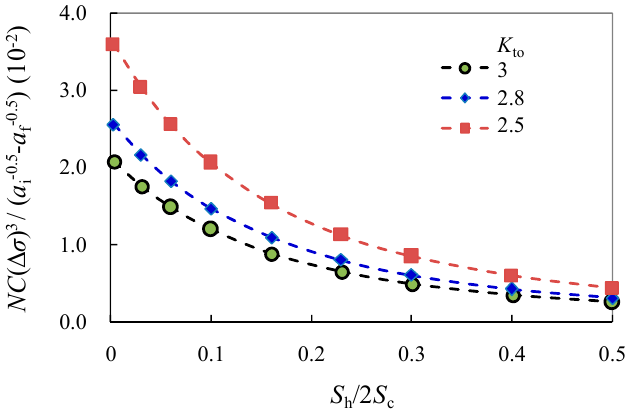
3 / ( a − 0.5 − a − 0.5 ) and S i f